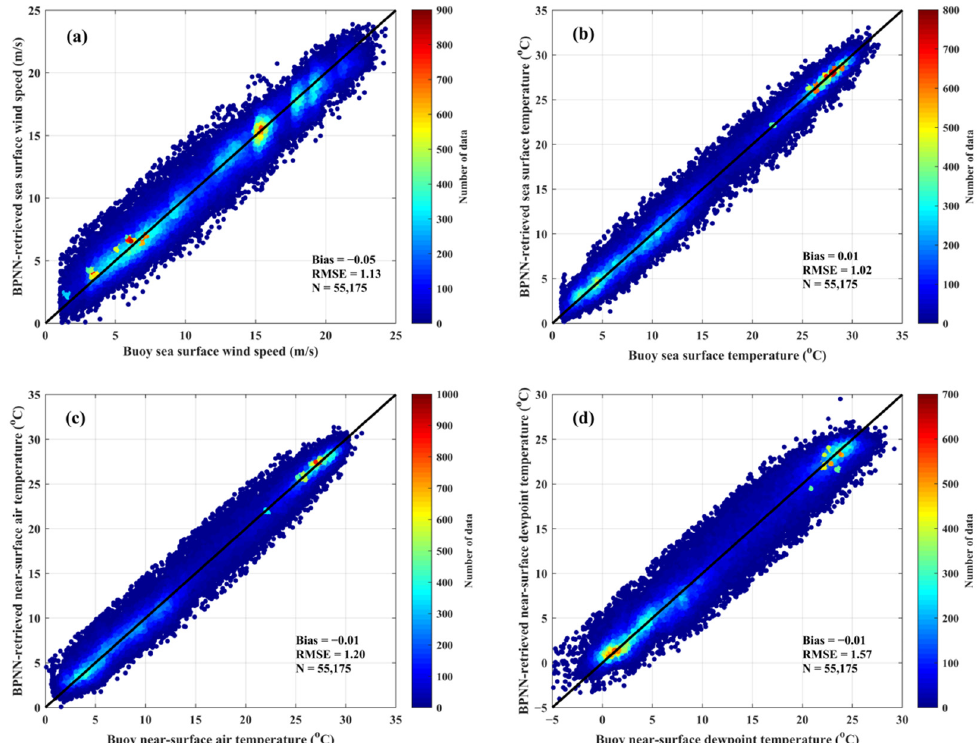
Figure 3. The comparisons between BPNN retrievals from AMSR2 observations under both clear and cloudy weather conditions and those from buoy and ECMWF ERA5 data for ( a ) sea surface wind speed (WS), ( b ) sea surface temperature (T s ), ( c ) near-surface air temperature (T a ), and ( d ) near- surface dewpoint temperature (T d ) over the global oceans, for 55,175 data points from 2012 to 2020. The colored bars represent the number of data points in the specific bins. The bin size is 0.5 × 0.5 m/s for ( a ) and 0.5 × 0.5 °C for ( b – d ). Each colored point is located at the center of the bin.